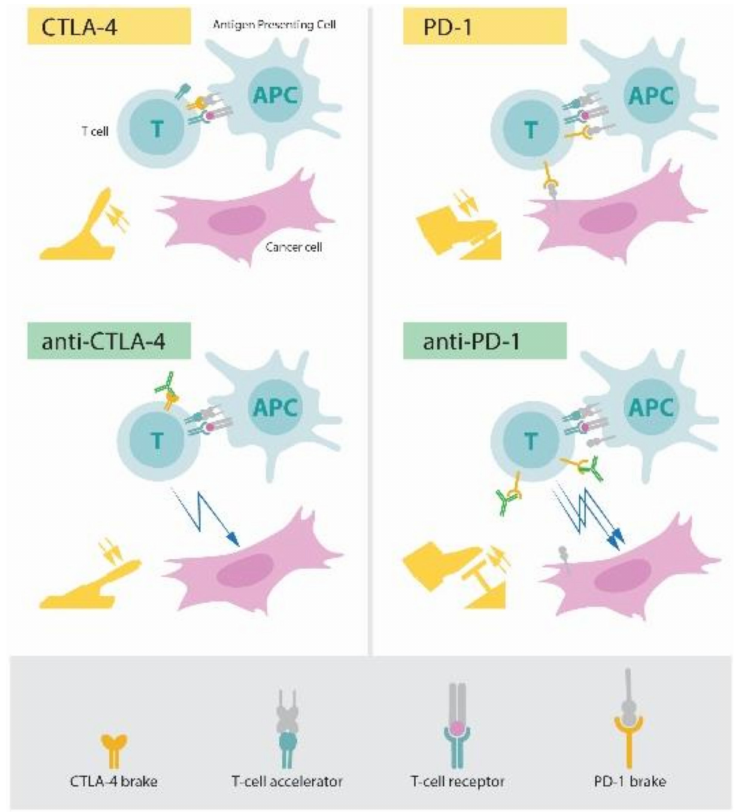
Figure 3. The principle for immune therapy. APC—antigen presenting cell; CTLA-4—cytotoxic T-lymphocyte antigen 4; PD-1—programmed death